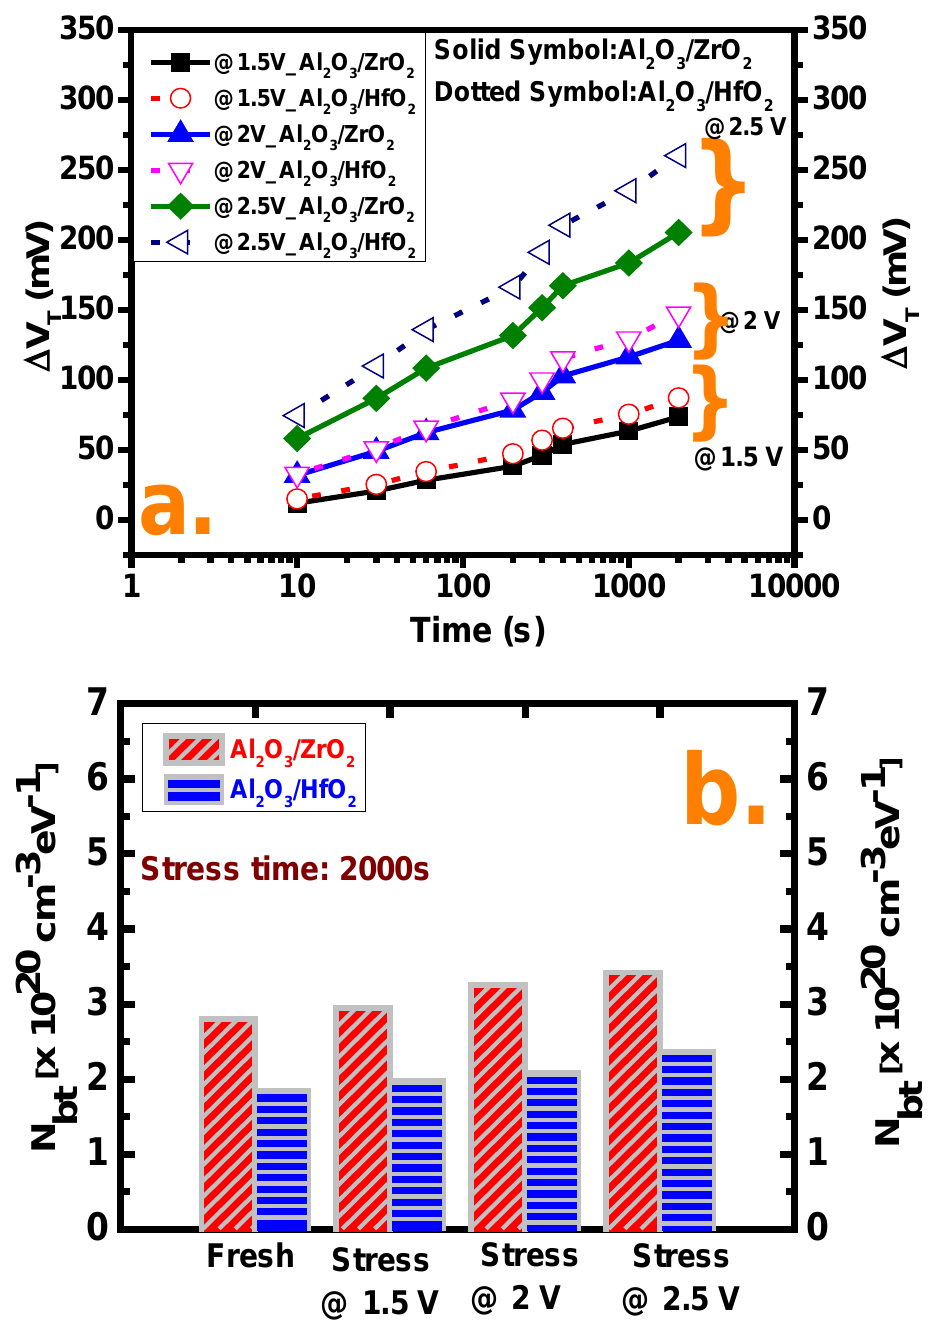
Figure 4. ( a ) Threshold voltage shift (V TH ) after constant voltage stress (CVS) at three different voltages for both samples. ( b ) Border trap density (N bt ) characterizations of both cases after CVS including fresh samples.